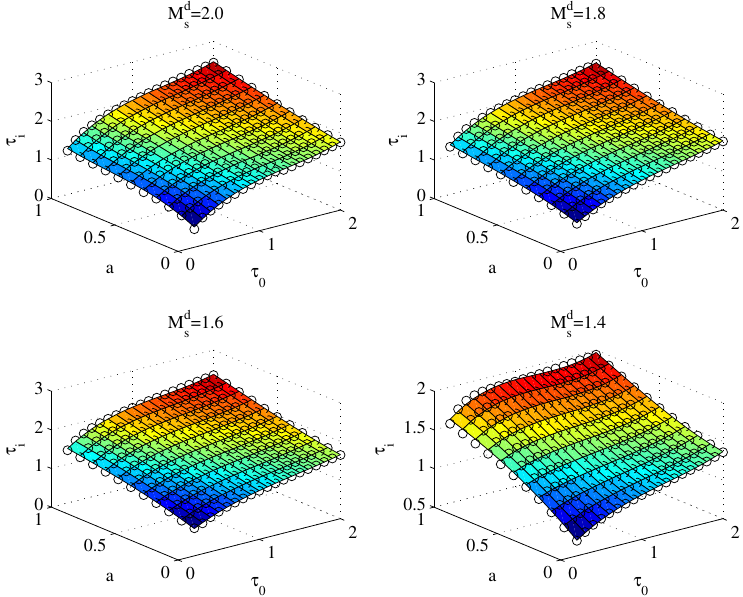
Figure 6. Calculated and approximated optimal τ i in the regulation